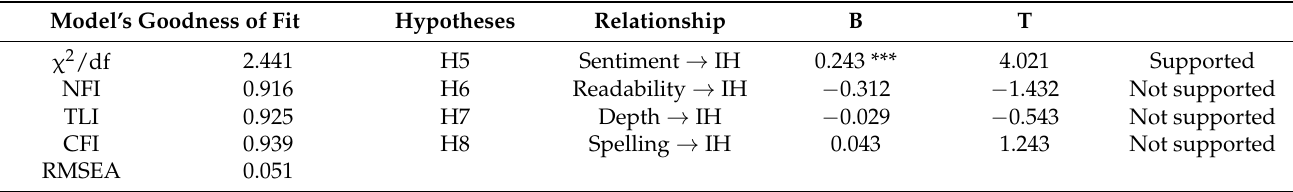
Table 4. Structural equation modeling and bootstrapped mediation analysis results.